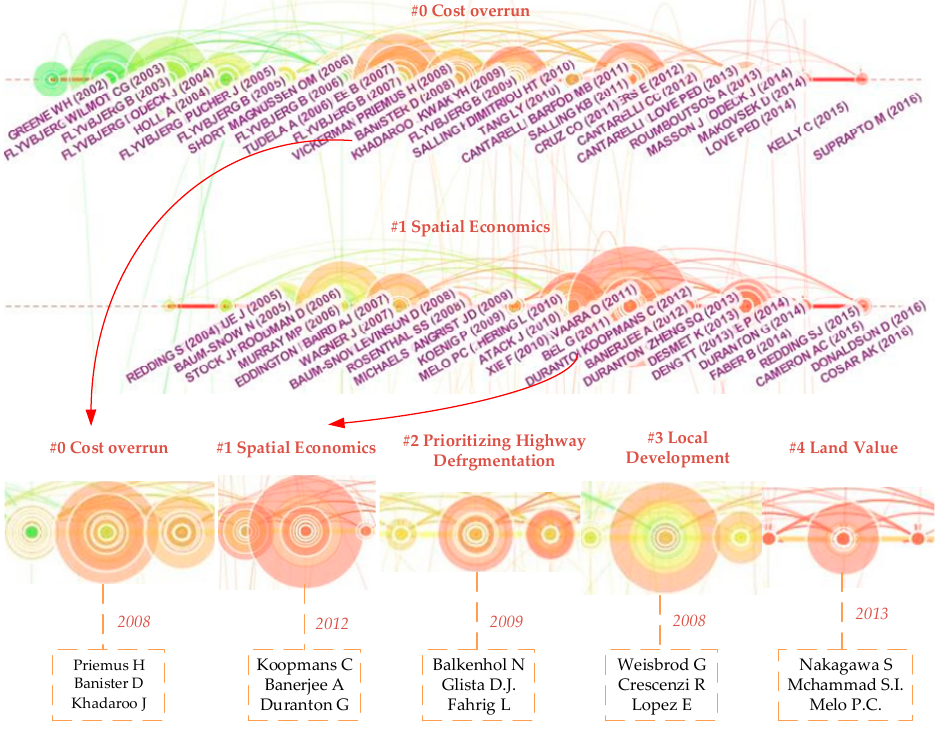
Figure 11. A timeline visualization of the largest clusters. Table 3. Temporal properties of the major 6